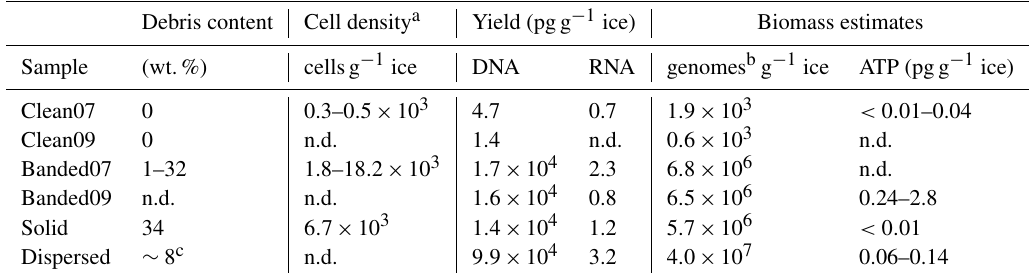
Table 2. Debris content, cell counts, biomass estimates, and yield of DNA and RNA extracted from basal ice samples. All measurements are normalized to sample wet